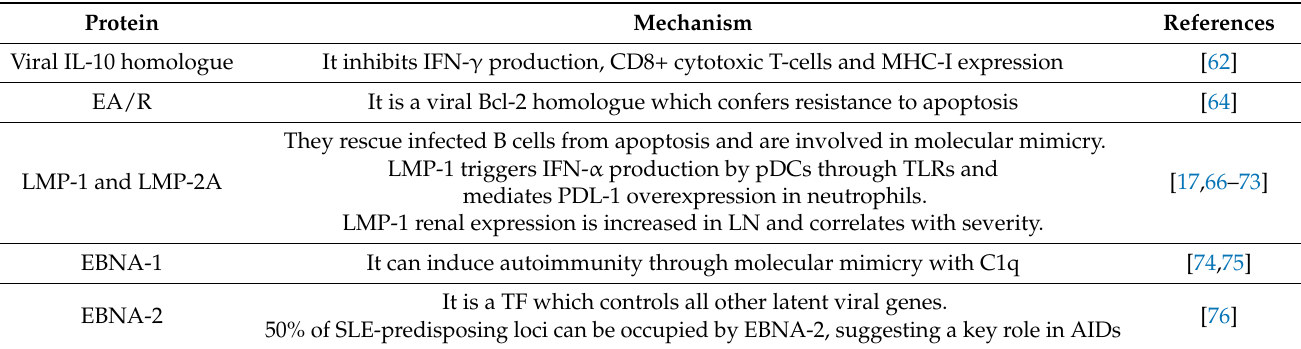
Table 3. EBV proteins involved in immune system evasion and autoimmunity induction. Protein